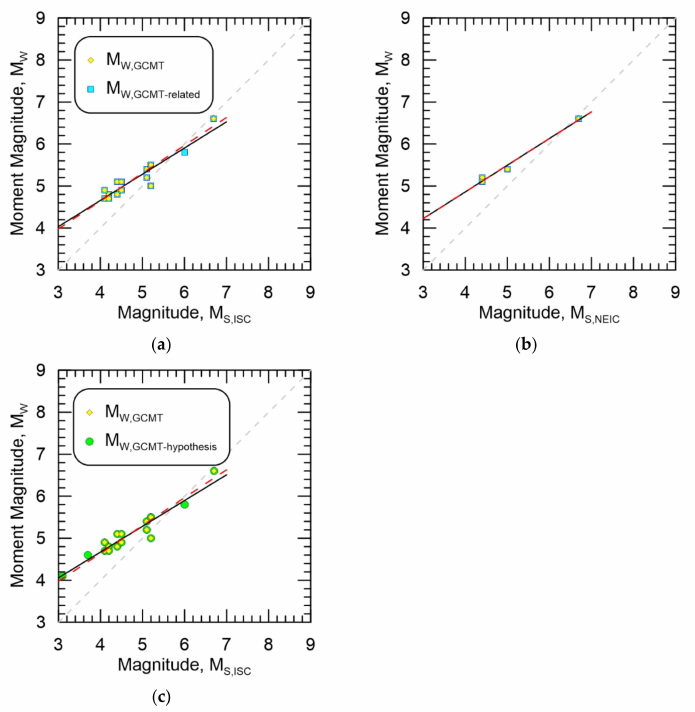
Figure 12. Resultant magnitude homogenization regressions for M W,GCMT-related against ( a ) M S,ISC , ( b ) M S,NEIC , and M W,GCMT-hypothesis against ( c ) M S,ISC . Data from M W,GCMT are also shown. Black line is the regression against M W,GCMT-related or M W,GCMT-hypothesis while the dashed red line is the regression against M W,GCMT